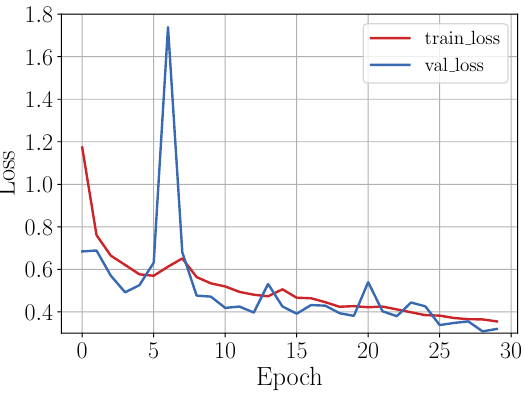
Figure 8. Loss behavior during training